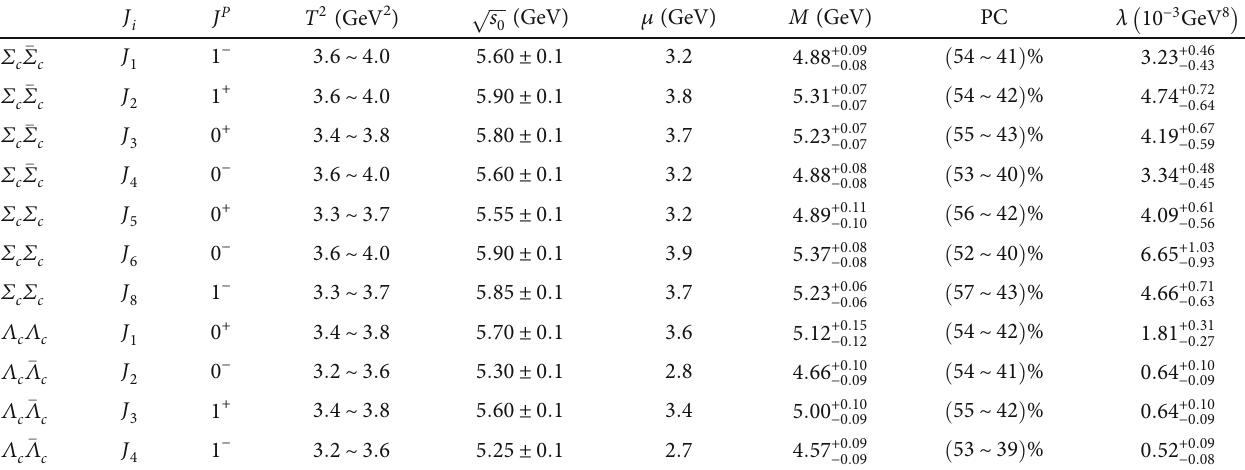
Table 1: The related numerical results extracted from the Borel windows of the seven